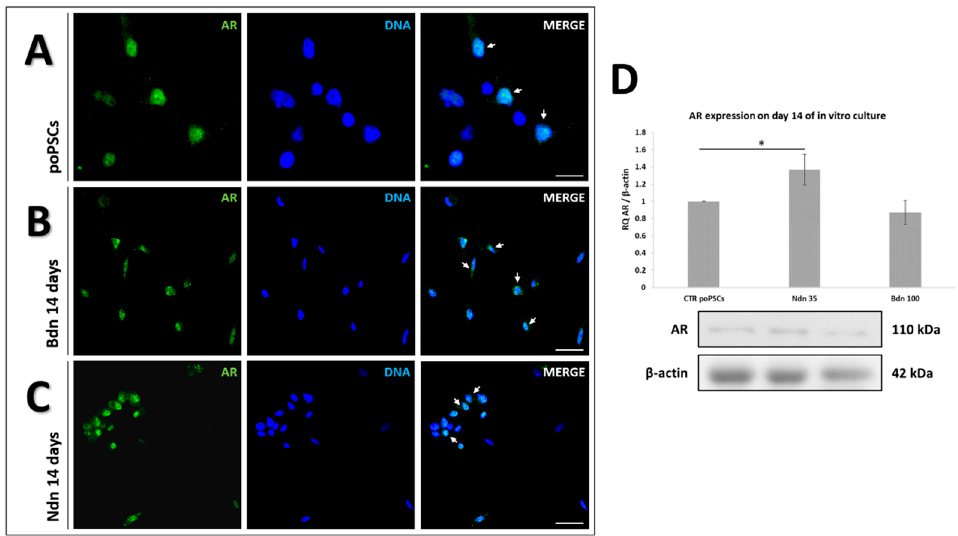
Figure 1. The presence and localization of AR in poPSCs cultured without the addition of anabolic steroids ( A ) and in poPSCs cultured for 14 days in the presence of boldenone at a dose of 100 µM ( B ) and nandrolone at a dose of 35 µM ( C ). Green signal-AlexaFluor 488 fluorescent dye, blue signal–DAPI; scale bars represent 50 µm in A and 100 µm in B and C. The immunofluorescence staining was repeated thrice; the figure shows the best representative micrographs selected from 3 replicates. Expression of AR at the level of total protein after 14-Day culture in the presence of nandrolone and boldenone ( D ). The graphs depict the relative abundances (RAs) noticed for AR obtained from measurements of the optical density of the bands representing a specific signal. Results represent the mean with n = 3 ± standard deviation (SD). Statistical analysis: homogeneity of variance—Levene’s test, normality of distribution-Shapiro–Wilk test, one-way ANOVA, Tukey’s post-hoc test, * p < 0.05.